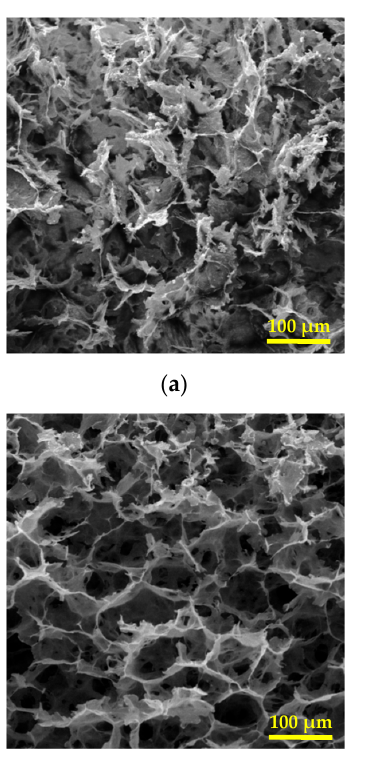
Figure 4. Scanning electron micrographs of cross-sections of PHBV scaffolds: ( a ) HBV5-R2, ( b ) HBV5-R6, ( c ) HBV12-R2. Dashed-line circles present areas detected as platelet-like structures.